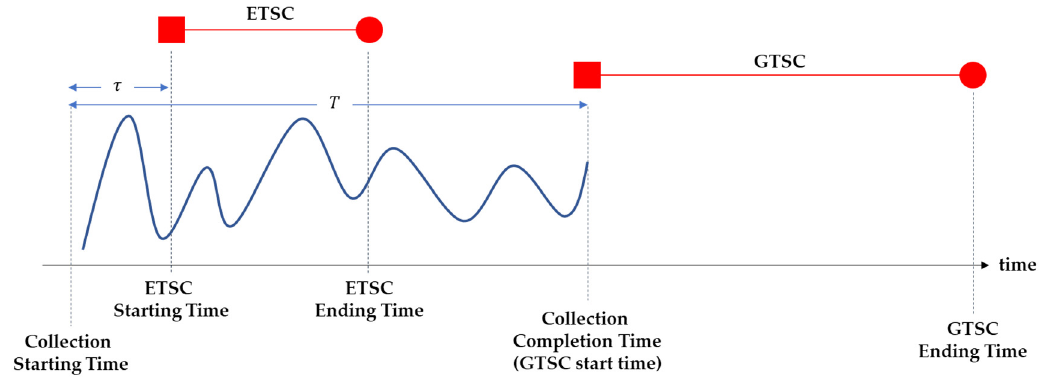
Figure 2. Comparison of general time series classification and early time series classification.